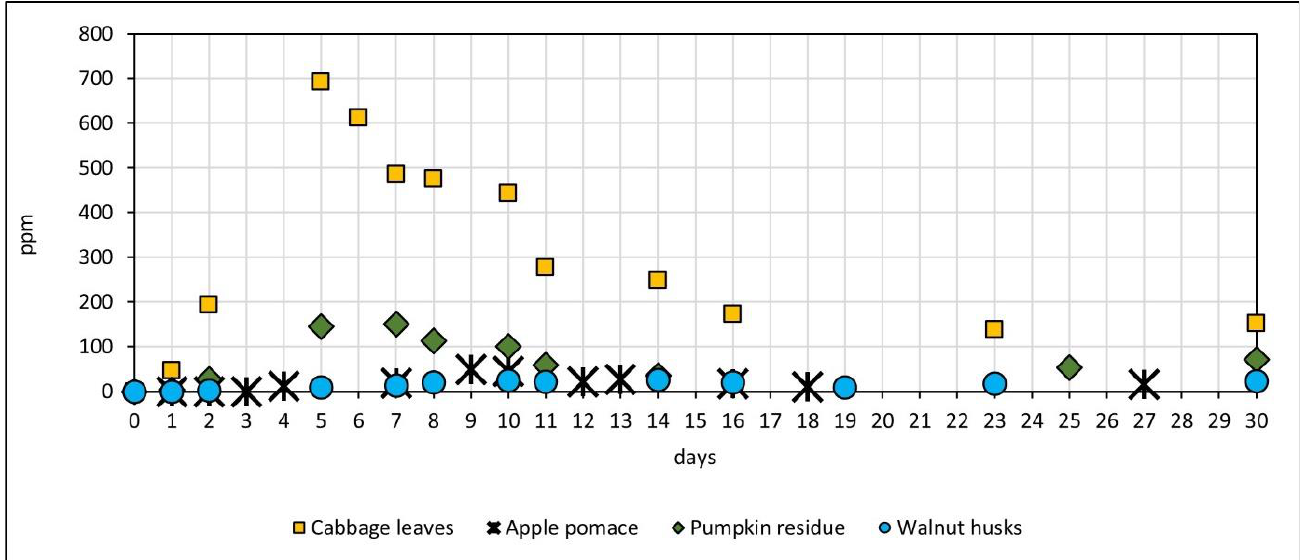
Figure 4. Concentration of the ammonia in biogas produced from four fruit and vegetable residues.